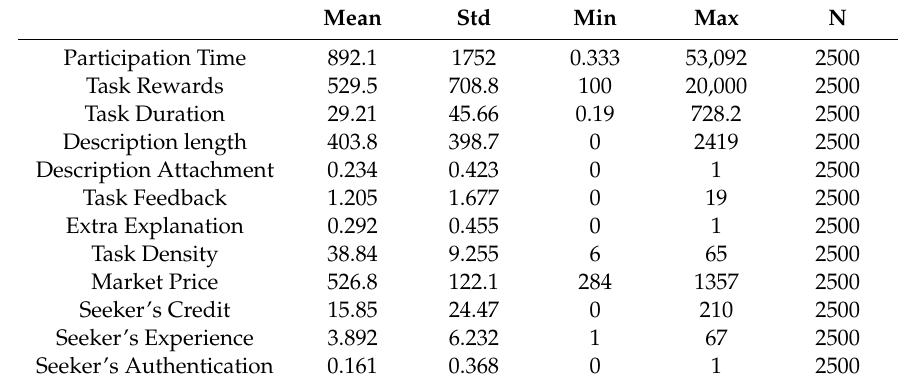
Table 2. Descriptive statistic.